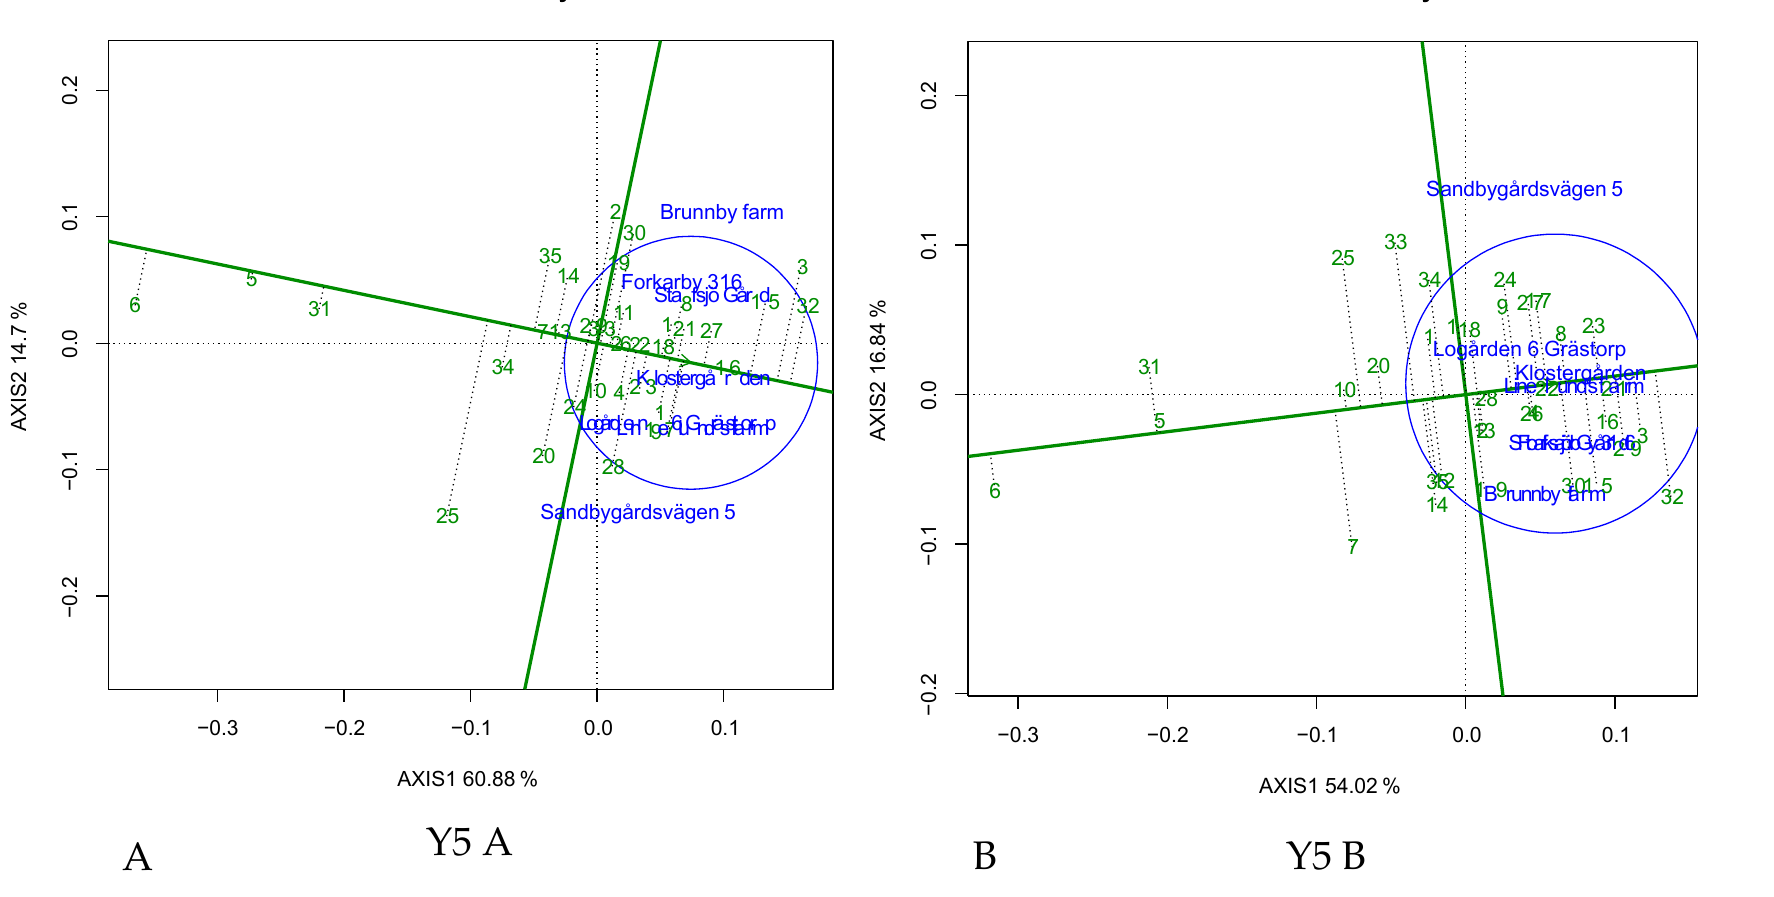
Figure 5. Average environment coordination (AEC) plots of barley genotypes for the mean genotypic performance and stability under untreated ( A ) and treated ( B ) conditions, across five years (Y1 to Y5).